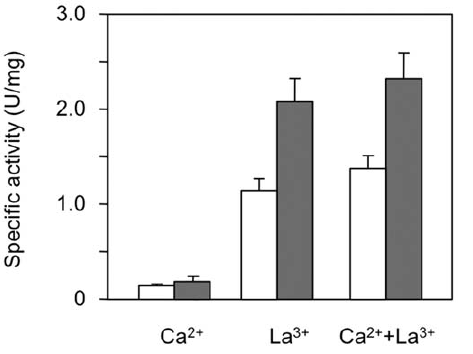
Figure 2. MDH activity in strain AM1 grown on the methanol and succinate media with Ca 2 + and/or La 3 + . Cells were grown aerobically in succinate (white bar) and methanol (gray bar) media with 30 m M La 3 + and/or Ca 2 + at 30 u C. Results are shown as means with standard deviations ( n =3).